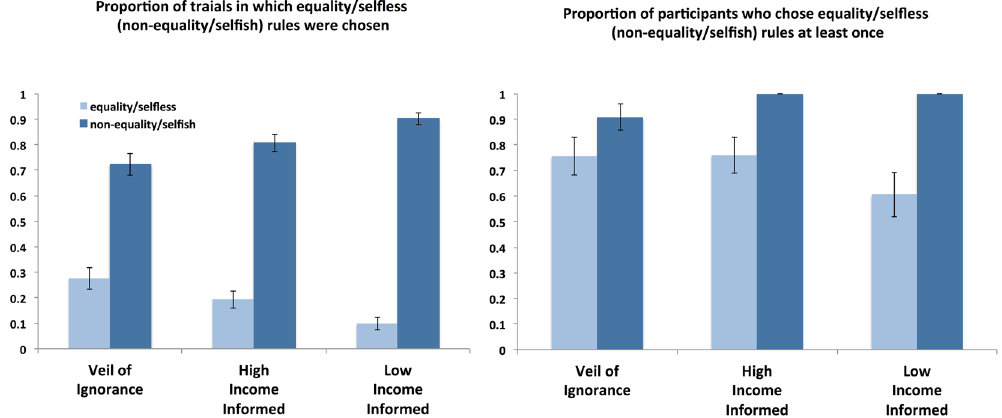
Figure 2. Behavioural analysis of decisions on redistribution rules. In the VoI condition, decisions on the equality rule were compared with those of non-equality (intermediate and inequality) rules. In the Informed condition, selfish decisions on inequality (equality) rules in high (low) classes were compared with selfless decisions, i.e., equality and intermediate (inequality and intermediate) rules. Data are expressed as mean ± s.e.m. Panel A: Proportion of trials in which equality/selfless (non-equality/selfish) rules were chosen in the VoI, High Income (Informed), and Low Income (Informed) conditions. Panel B: Proportion of participants who chose equality/selfless (non-equality/selfish) rules at least once in the VoI, High Income (Informed), and Low Income (Informed)